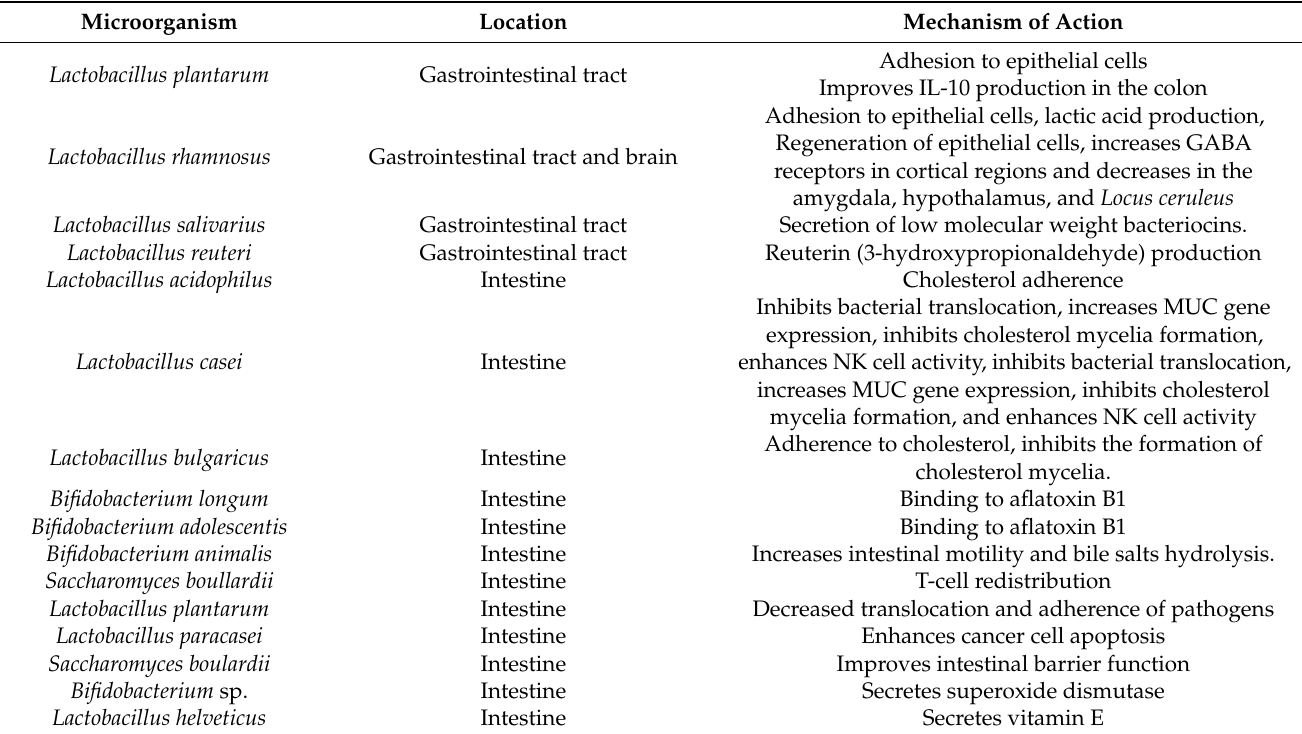
Table 1. The major species used as probiotics for the gastrointestinal tract in humans and their main locations and mechanisms of action